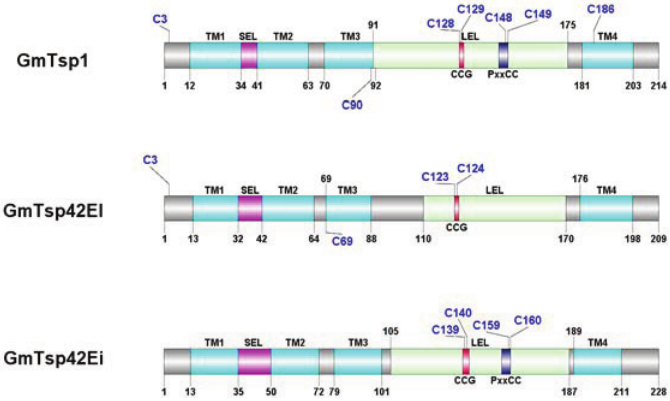
Figure A1. Distribution of the structural features of seventeen G. morsitans putative tetraspanins detected in this study: The start and end of the domains/motifs are indicated by the coordinates of the amino acid residues (shown with black numbers with vertical bars). The palmitoylation sites are shown in blue bold letters; the transmembrane domains (TM1–4) are depicted in light blue; the SEL motifs are in pink; the CCG domains are shown in red; the LEL motifs are shown in light green, while the PxxCC motifs are in dark blue. Notice that six of the GmTsps do not contain the PxxCC